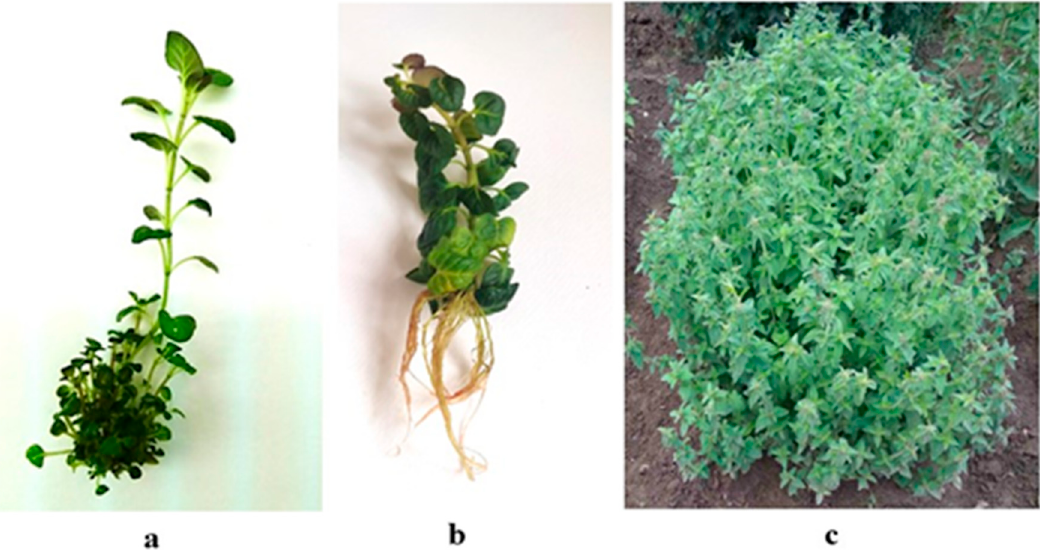
Figure 2. In vitro cultivation of Clinopodium vulgare L.: ( a ) shoot multiplication on MS medium supplemented with B1I0.1, ( b ) in vitro rooting on half-strength MS medium and ( c ) plants cultivated in the experimental